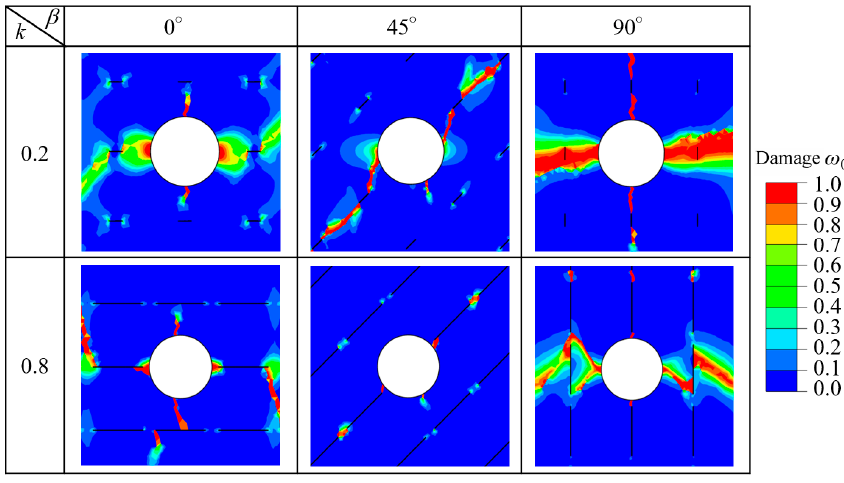
Figure 26. Damage distribution at σ 1 = σ p in the specimens with k = 0.2 and 0.8 at β = 0°, 45°, and 90°.